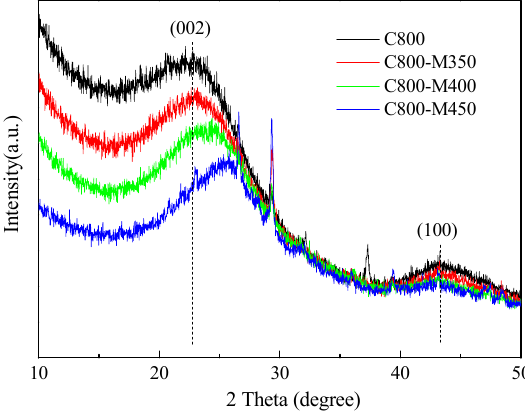
Figure 3. X-ray di ff raction (XRD) patterns of wood-derived porous carbons Figure 3. X-ray diffraction (XRD) patterns of wood-derived porous carbons materials.